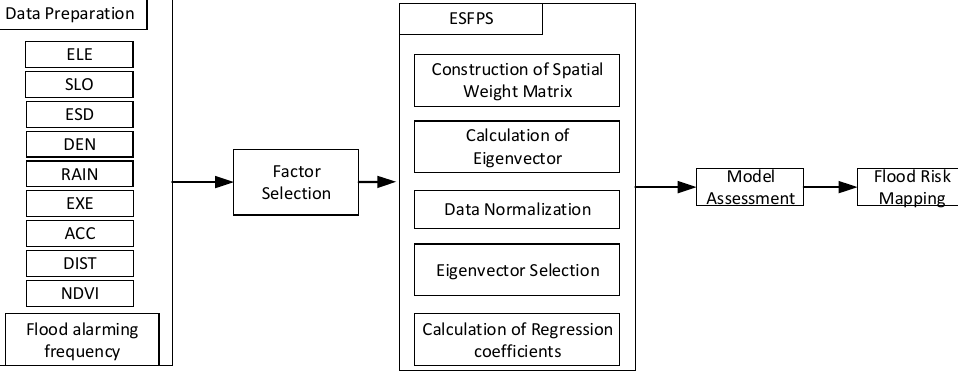
Figure 14. Flowchart of the study.